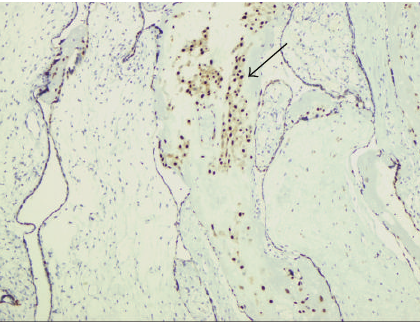
Figure 9: p 57 KIP2 positivity in extravillous trophoblast nuclei (original magnification ×10